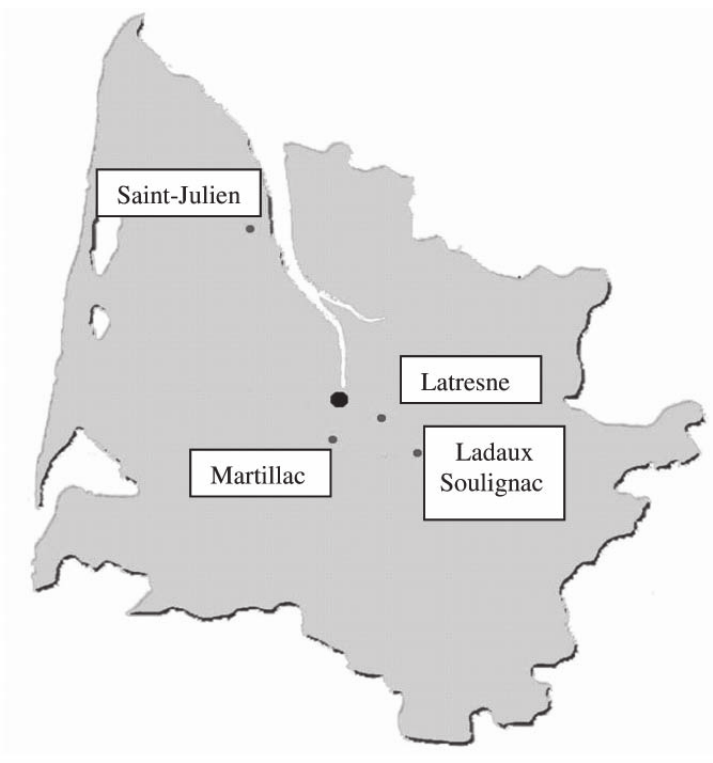
Fig. 1. Location of vineyards of the Bordeaux area in which the injection experiments were carried